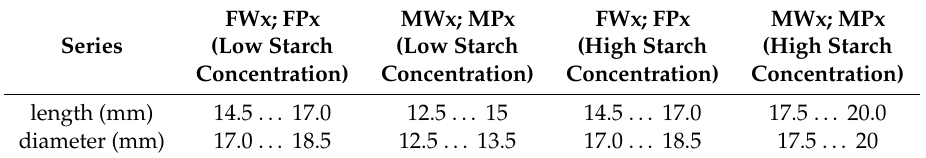
Table 2. Geometrical size of carbon monoliths obtained from di ff erent precursor